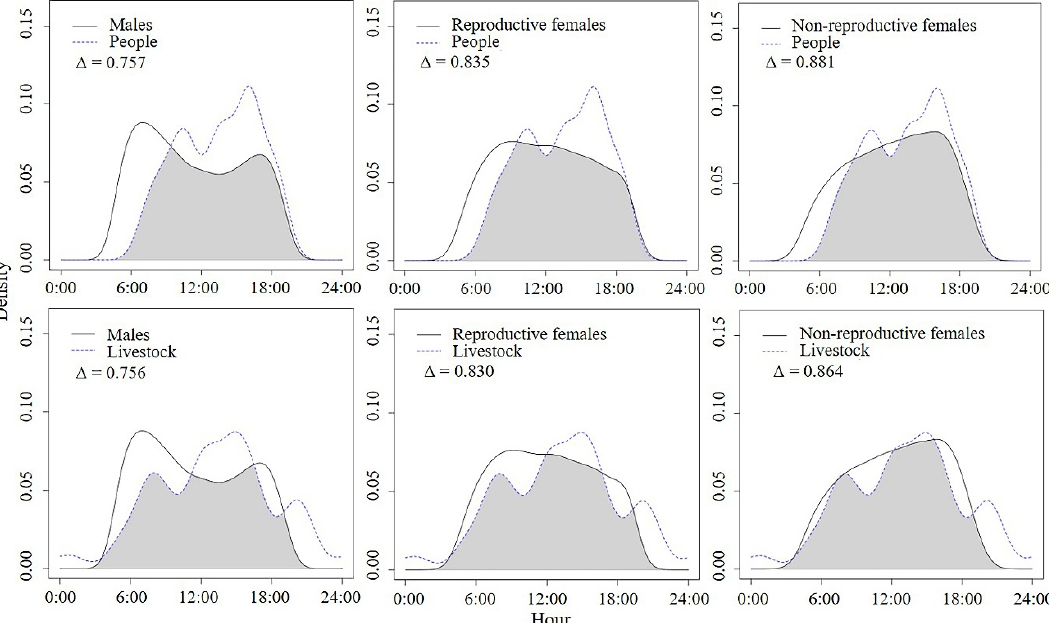
Figure 1. Diel movement patterns of Reeves’s Pheasants during the breeding season.